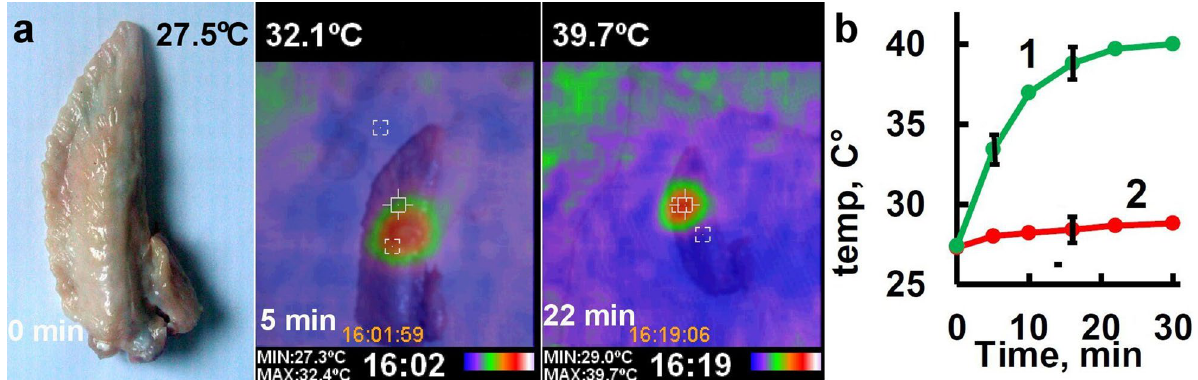
Figure 4. Alternating magnetic field induced local heating in chicken wing with injected MCZ nanoparticles ( a ) and monitoring of the temperature in the MCZ injection site (1) and the temperature at a distance of 2 cm from the site of injection in time (2) ( b